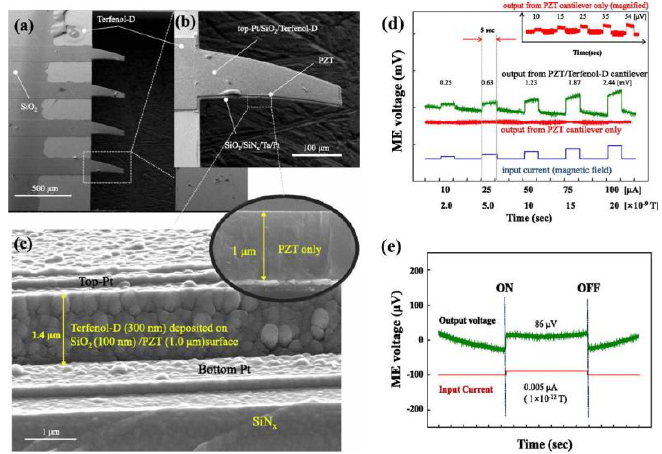
Figure 10. SEM images and ME properties of ME microcantilever array consisting of Terfenol-D and PZT thin film